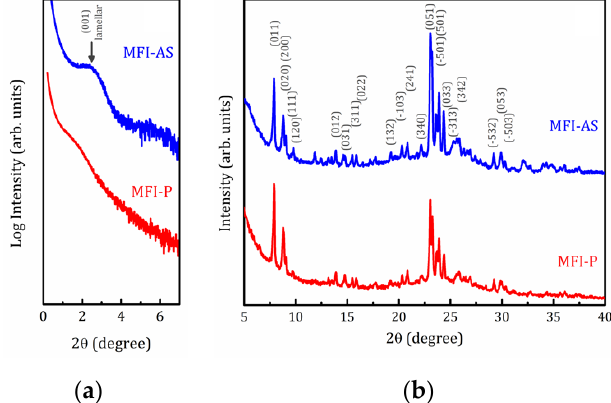
Figure 2. Small-angle ( a ) and full ( b ) XRD powder patterns for the ZSM-5 samples as synthetized (MFI-AS) and pillared (MFI-P).